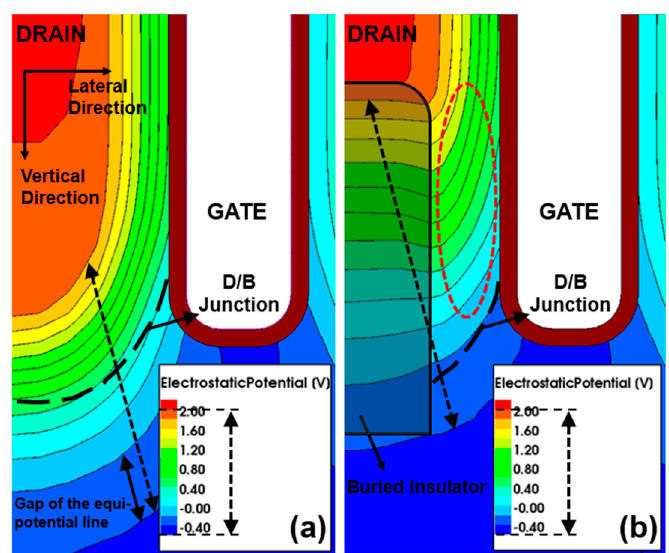
Figure 3. Potential contour indicating equipotential line distribution near the drain region at V DS = 1.5 V, V GS = − 0.5 V. ( a ) Conventional S-FinFET, ( b ) Pi-FinFET. Dotted arrows indicate potential drop width (PDW) from 1.8 V to − 0.4 V, while dotted red ellipse shows wider PDW compared to conventional S-FinFET.